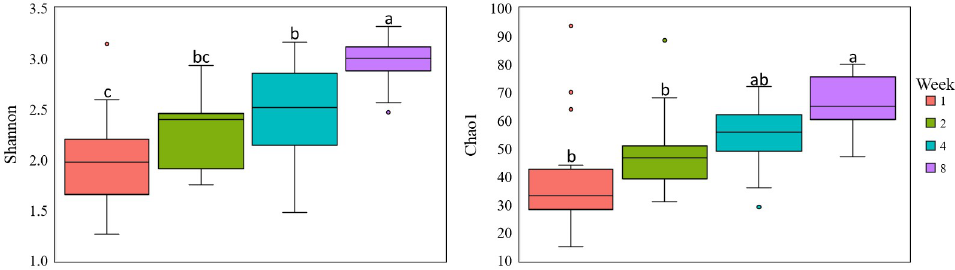
Fig 1. α -diversity in dairy calves’ feces fed milk replacer supplemented or not with β -glucans. Letters above boxes indicate significant differences at P < 0.05. Data are visualized as box-plots showing the median and the interquartile (midspread) range (boxes containing 50% of all values), the whiskers (representing the 25 and 75 percentiles) and the extreme data points.